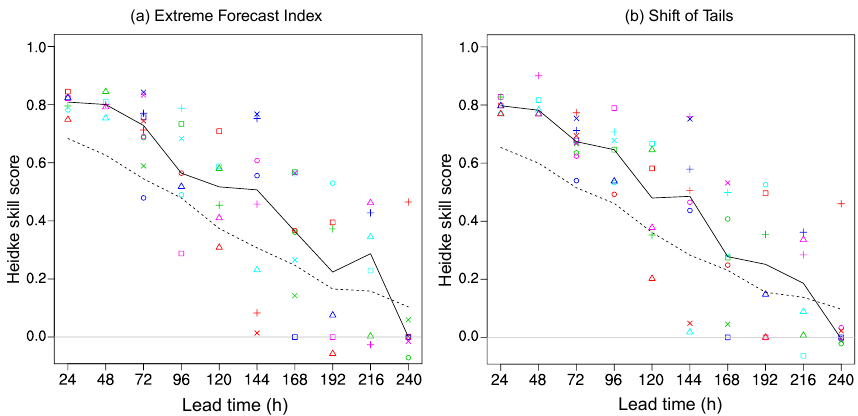
Figure 10. Heidke skill score for predicting gusts exceeding the local 98th climatological percentile of ERA-Interim using the Extreme Forecast Index ( a ) and the Shift Of Tails ( b ). The symbols represent the storms as given in Table 1 and the black curve shows the median of the storms per lead time, while the dashed curves illustrate the whole dataset for reference as in Fig.